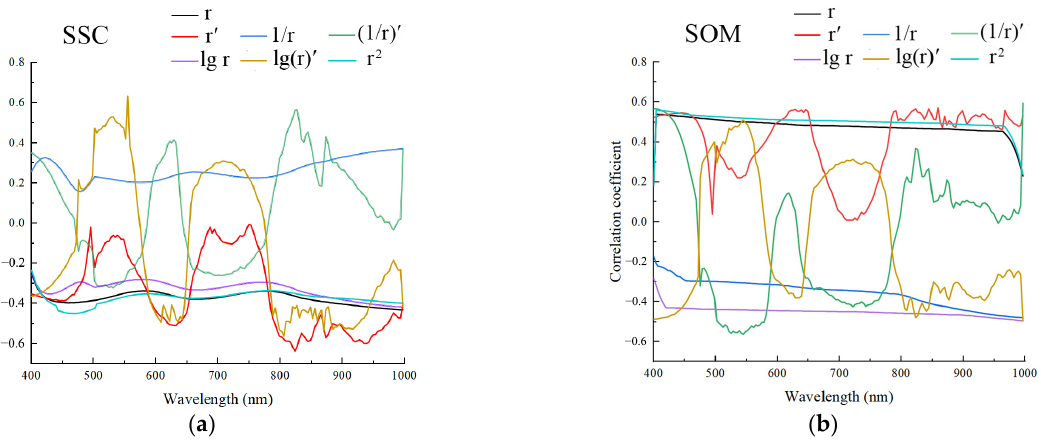
Figure 4. Correlations between hyperspectral reflectance and ( a ) SSC and ( b ) SOM under different mathematical transformations.